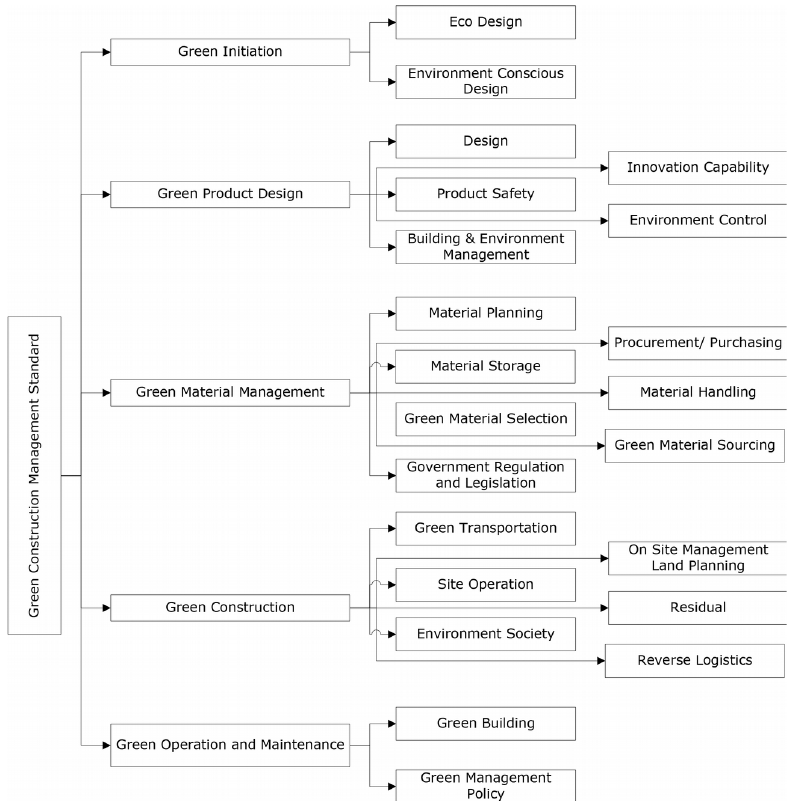
Figure 3. Framework for GSCM in the construction